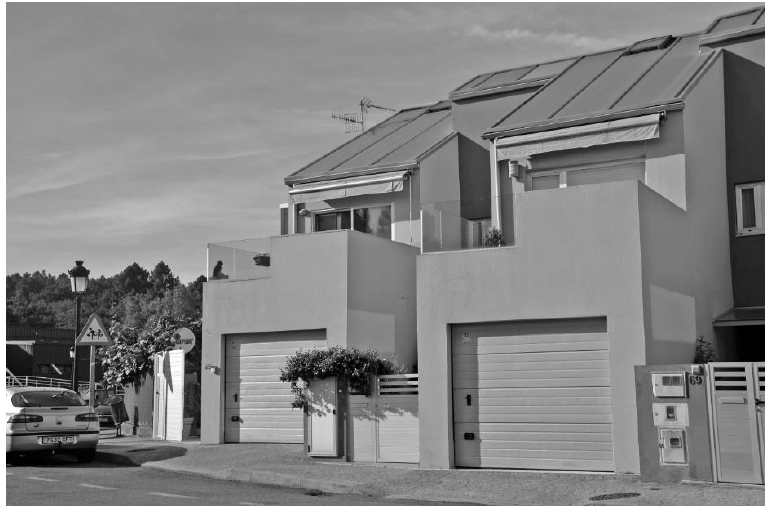
Figure 6. Social Housing in Pereiro de Aguiar (Pontevedra, 2006), by Teresa Táboas Veleiro. Photo credit: mccl arquitectos.